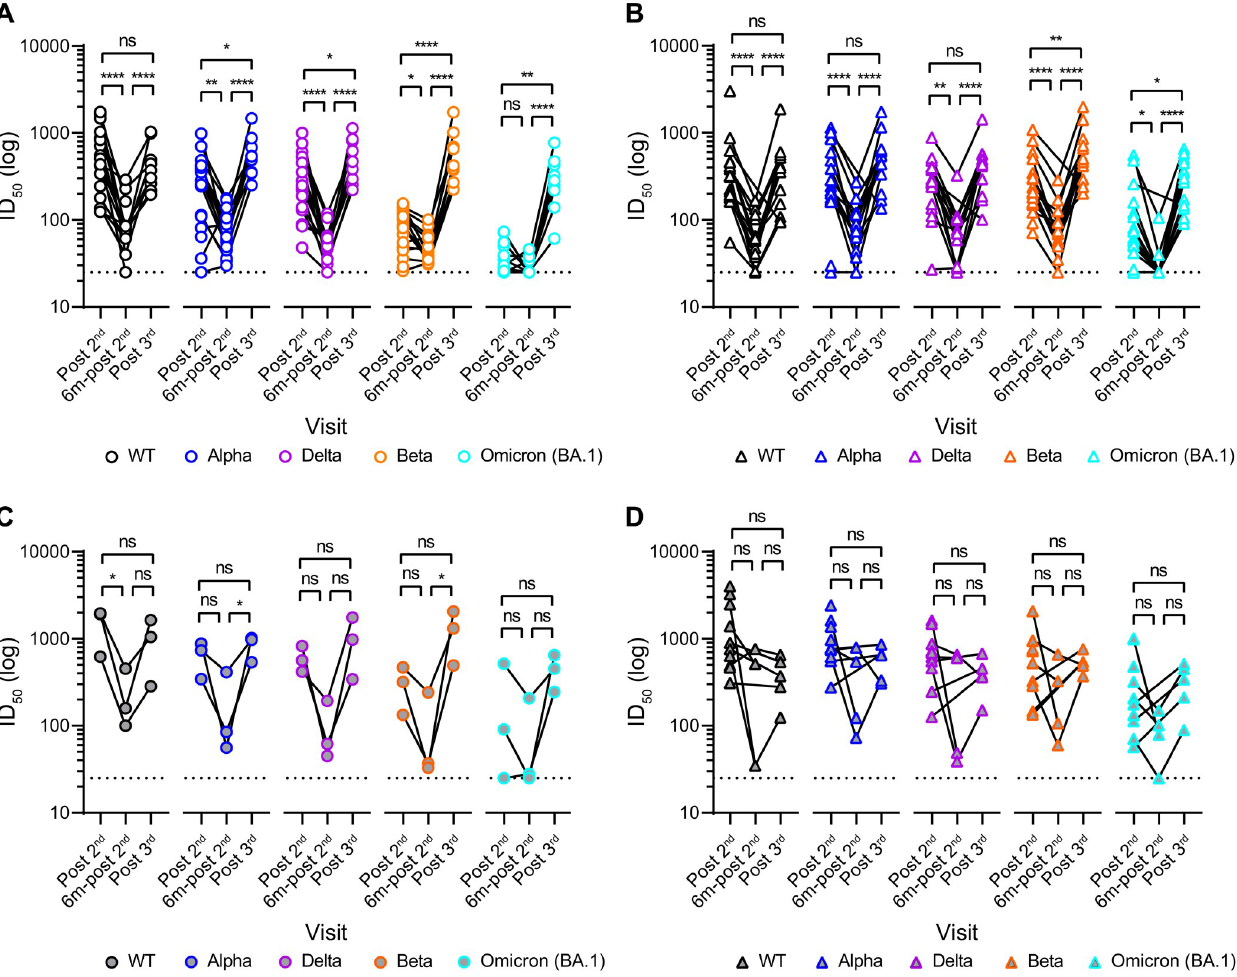
Fig 5. Neutralization potency decreases 6-months post 2 nd vaccine but breadth and potency increase after a 3 rd vaccine dose. Neutralization ID 50 against WT, alpha, delta, beta and omicron/BA.1 post 2 nd , 6 months post 2 nd and post 3 rd vaccine for A) SARS-CoV-2 na ï ve individuals in the short-group (circle) and B) SARS-CoV-2 na ï ve individuals in the extended-grous (triangle) and C) previously infected individuals in the short-group (grey circle) and D) previously infected individuals in the extended-group (grey triangle). Difference between GMT post 2 nd , 6 months post 2 nd and post 3 rd vaccine were determined using Mann-Whitney unpaired t-test. D’Agostino and Pearson tests were performed to determine normality. Based on this result, differences between groups were assessed using either one-way ANOVA (Tukey’s multiple comparisons post hoc), Kruskal-Wallis test (Dunn’s multiple comparisons post hoc) or Friedman test (Dunn’s multiple comparisons post hoc). ns P > 0.05, � P � 0.05, �� P � 0.01, ��� P � 0.001 and ���� P �